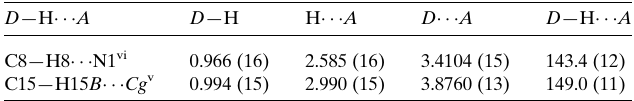
Table 1 Hydrogen-bond geometry (A˚ , (cid:2) ).